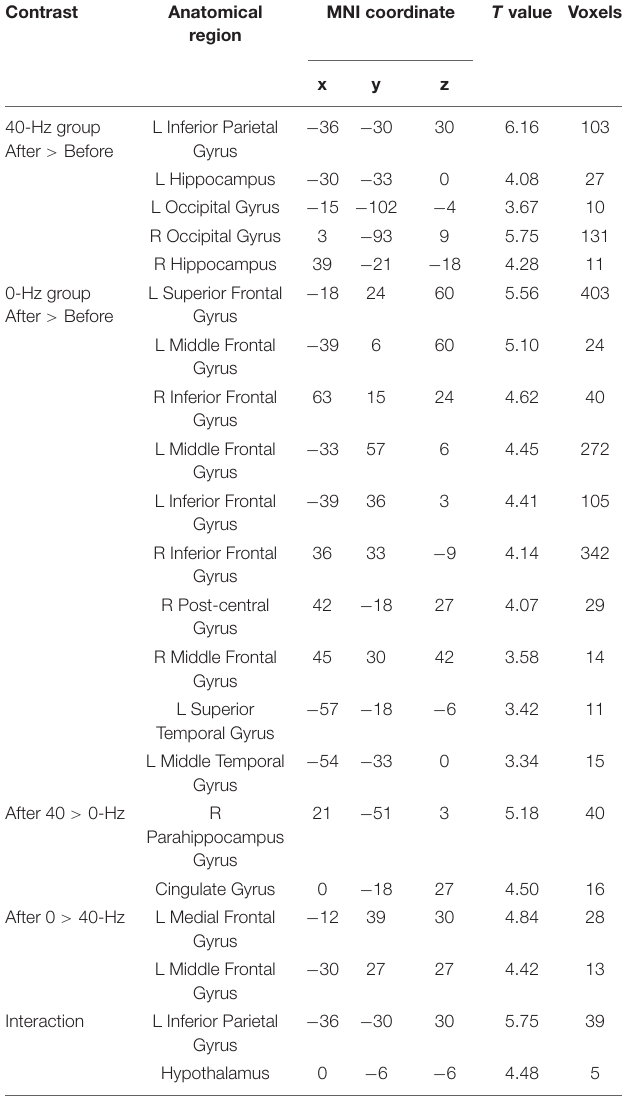
TABLE 1 | Intra- and inter-group differences under the condition of light stimulation ( P < 0.05, FDR corrected with a minimum cluster extent of 10 contiguous voxels). Contrast Anatomical